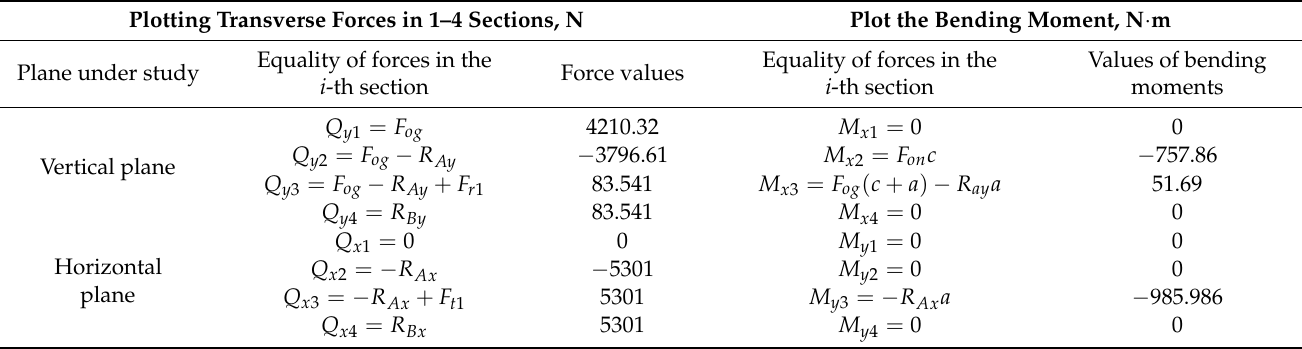
Table 3. Calculated equations of transverse forces and bending moments acting in the transmission shaft. Plotting Transverse Forces in 1–4 Sections, N Plot the Bending Moment, N · m Equality of forces in the Values of bending Equality of forces in the Force values Plane under study i -th section i -th section moments